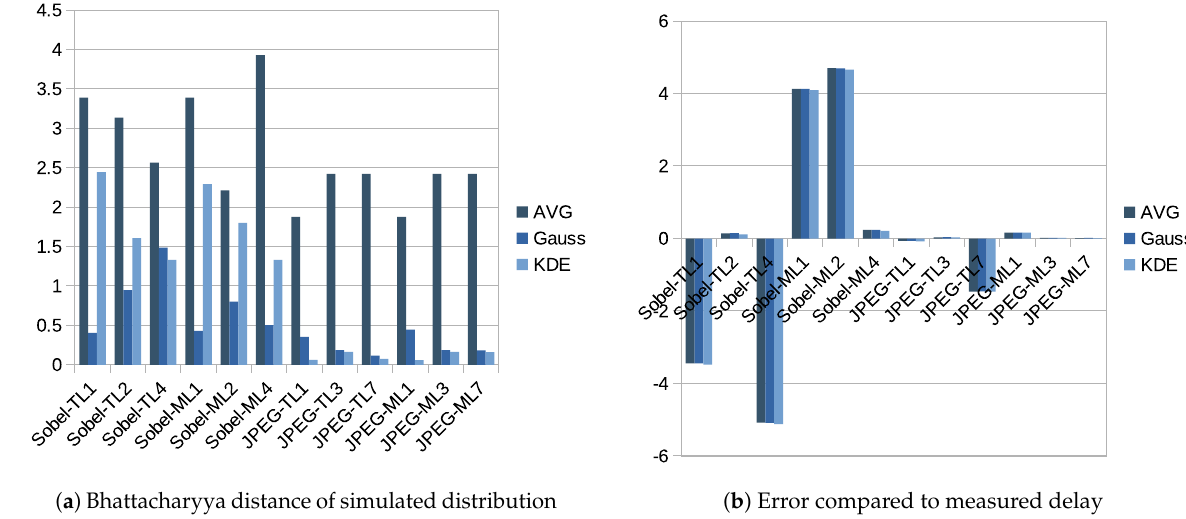
Figure 8. Comparison of the simulation results to the observed behavior of the Use-Cases on a real